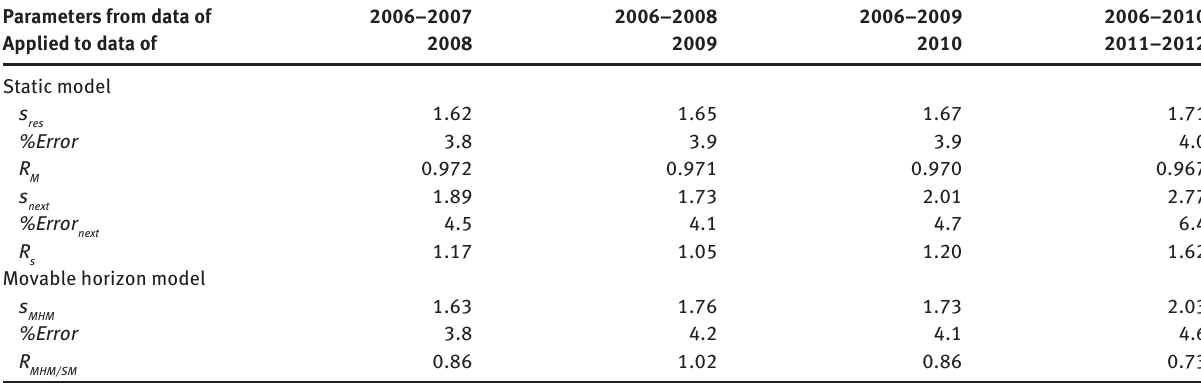
Table 4 Results of model Str_28_1 .